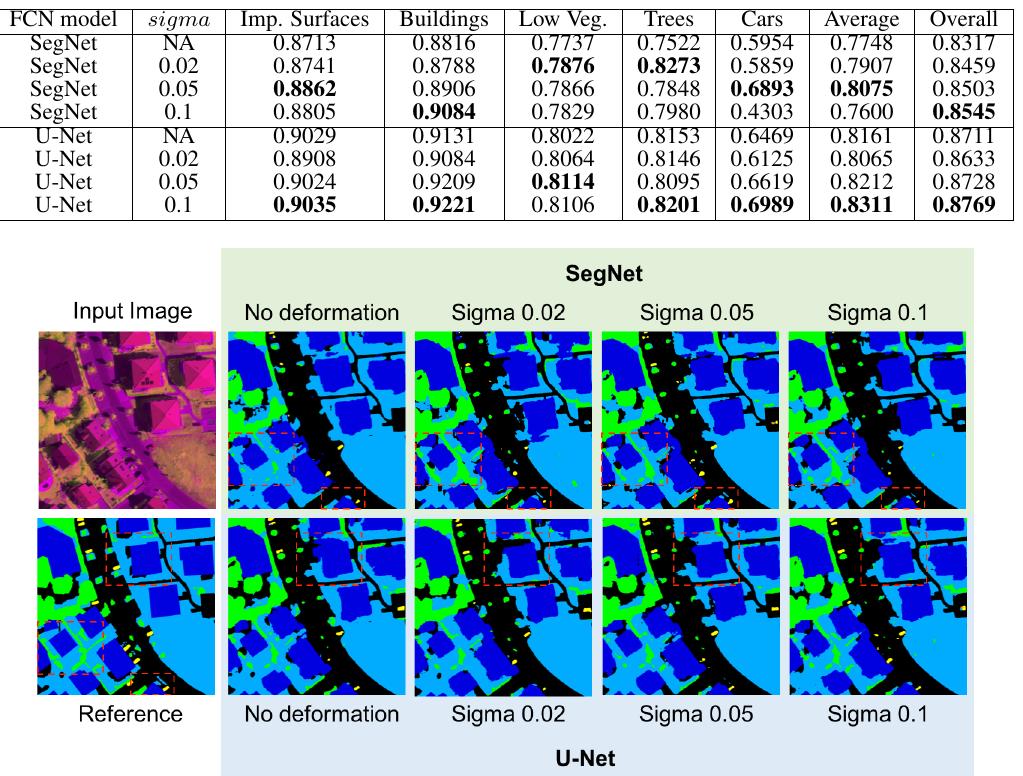
Table 1. F1-scores for the different tested models: average by class and overall.